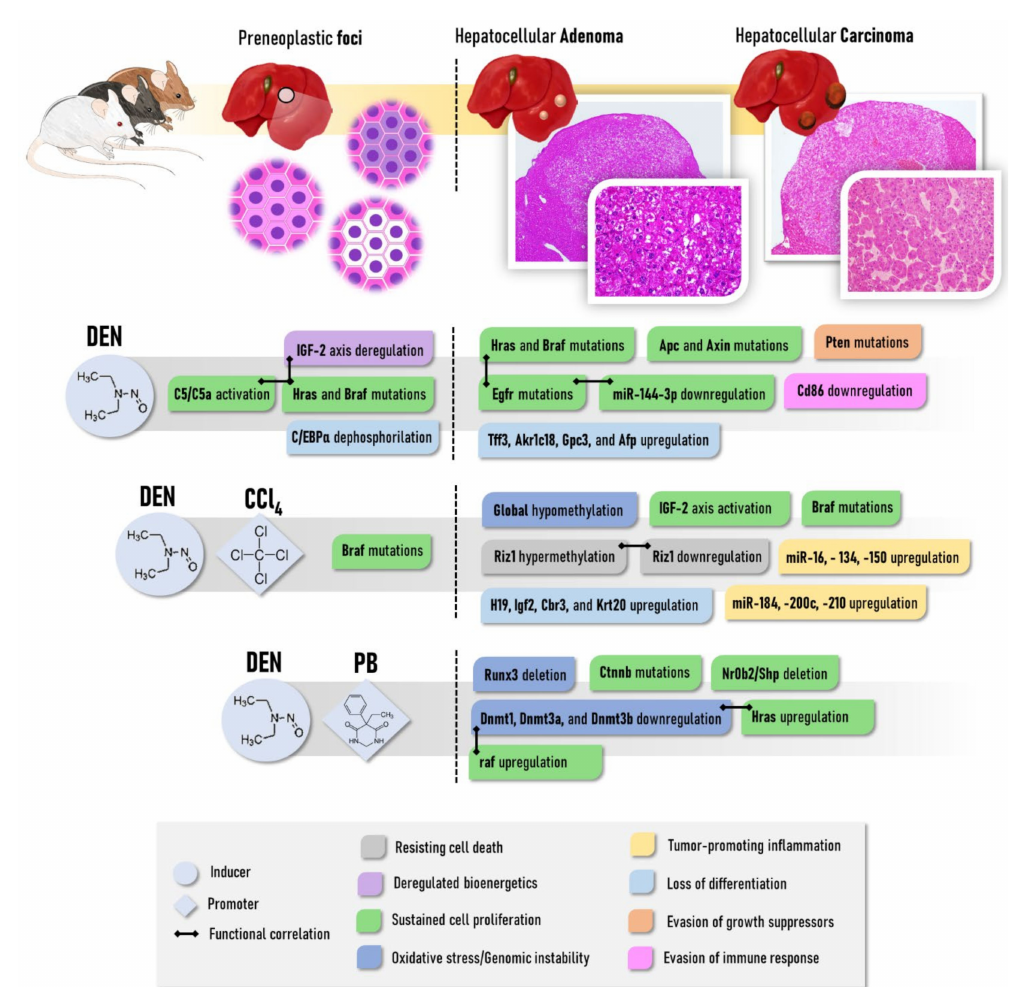
Figure 1. General depiction of the main molecular alterations and functional hallmarks involved in the development of preneoplastic (foci) and neoplastic (adenomas and carcinomas) lesions in widely-applied chemically induced models in mice. Strain-related and protocol-related variations should be considered. At late stages, molecular alterations are usually screened in a pool of neoplastic alterations, not considering if they are benign or malignant. CCl 4 : carbon tetrachloride; DEN: diethylnitrosamine; PB: phenobarbital. The figure was composed with the aid of illustrations from the SMART-servier Medical Art available at https://smart.servier.com/ (accessed on 15 January